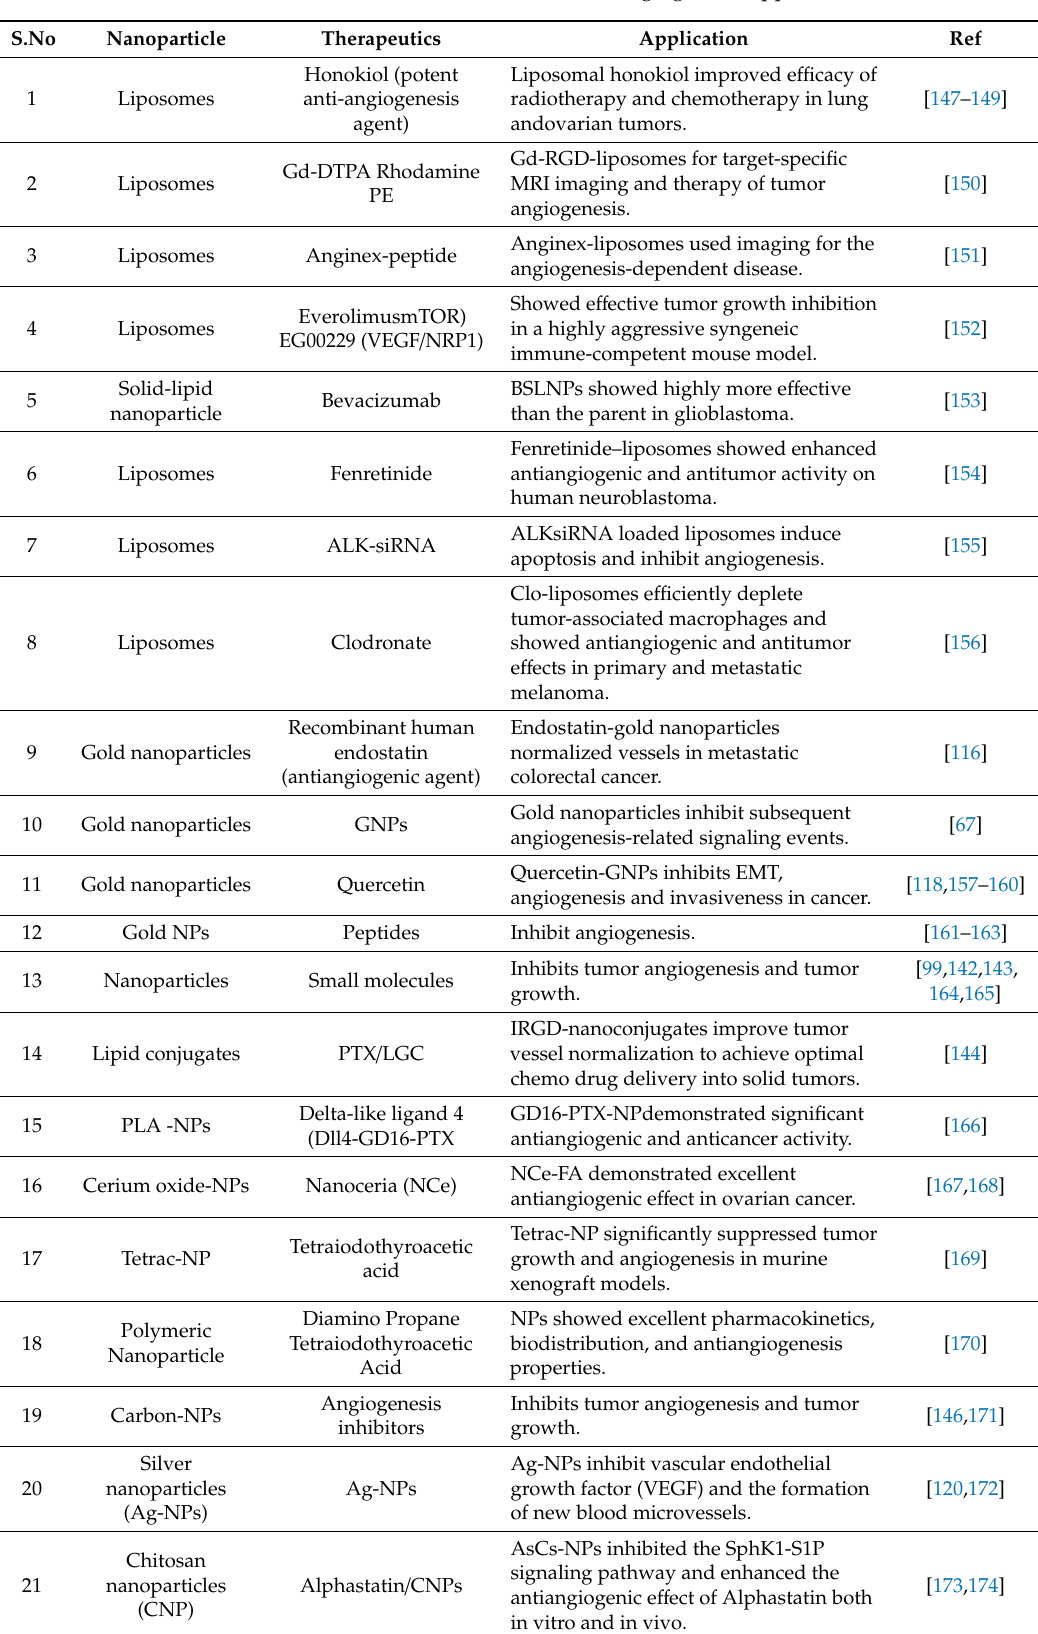
Table 2. Various nanomaterials and their anti-angiogenesis